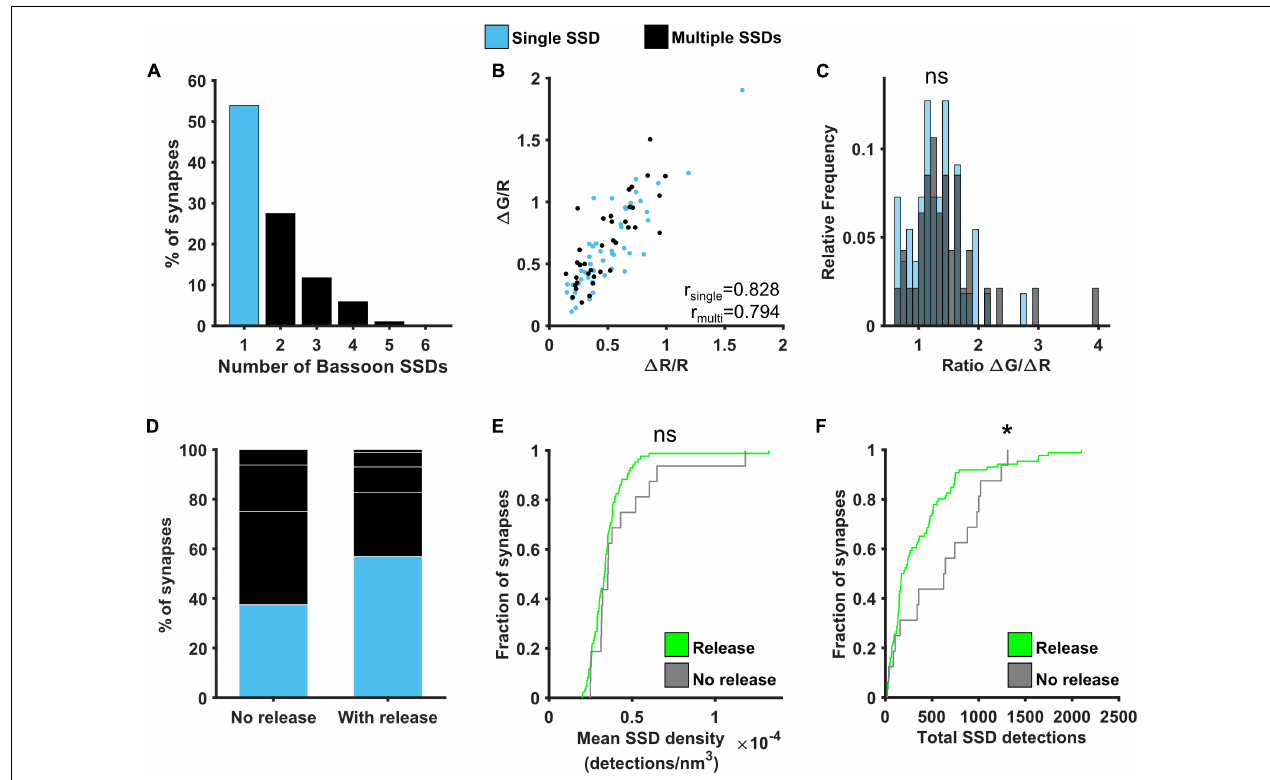
FIGURE 6 | Effect of Bassoon nanoscale organisation on neurotransmitter release. (A) Distribution of the number of Bassoon SSDs per synapse. (B) (cid:49) G/R and (cid:49) R/R responses from synapses post hoc labelled for Bassoon and identified as containing a single (blue) or multiple (black) Bassoon SSDs show a positive correlation (Spearman’s rank correlation, r single = 0.828, p < 0.001, n single = 49 synapses, r multi = 0.794, p < 0.001, n multi = 37 synapses). (C) Distribution of the ratio (cid:49) G/ (cid:49) R for the two group of synapses. Distributions are not significantly different (Kolmogorov-Smirnov test, p = 0.575, n single = 49, n multiple = 37). (D) Percentage of synapses with single or multiple Bassoon SSDs in synapses without detectable release (left, n = 16) or with release (right, n = 86). White lines indicate separation of multiple SSDs by number. (E) Cumulative frequency distribution of the mean density of detections in Bassoon SSDs per synapse (number of detections/nm 3 ) in synapses with (green) or without (grey) detectable release to a 10AP stimulus (Kolmogorov-Smirnov test, p = 0.355, n release = 86, n norelease = 16). (F) Cumulative frequency distribution of the total number of detections in Bassoon SSDs per synapse in synapses with (green) or without (grey) detectable release to a 10AP stimulus (Kolmogorov-Smirnov test, p = 0.041, n release = 86, n norelease = 16). * p <